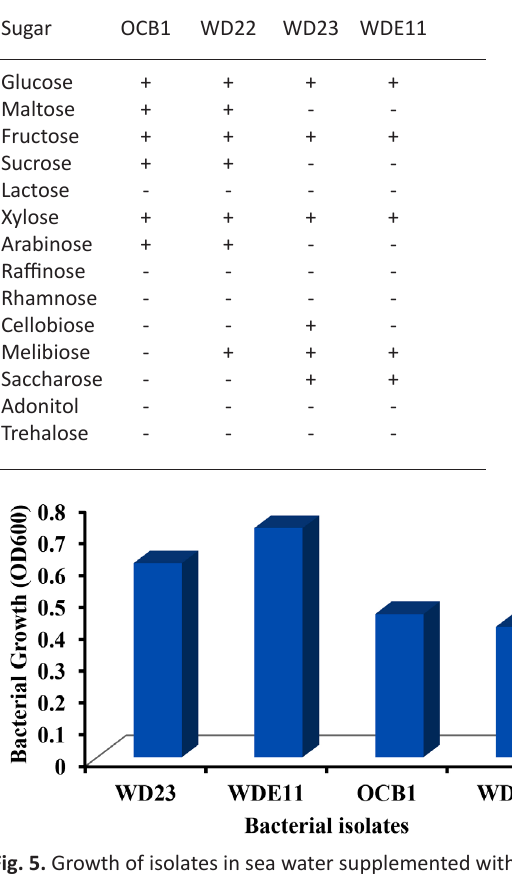
Table 7. Sugar hydrolysis results of isolated and